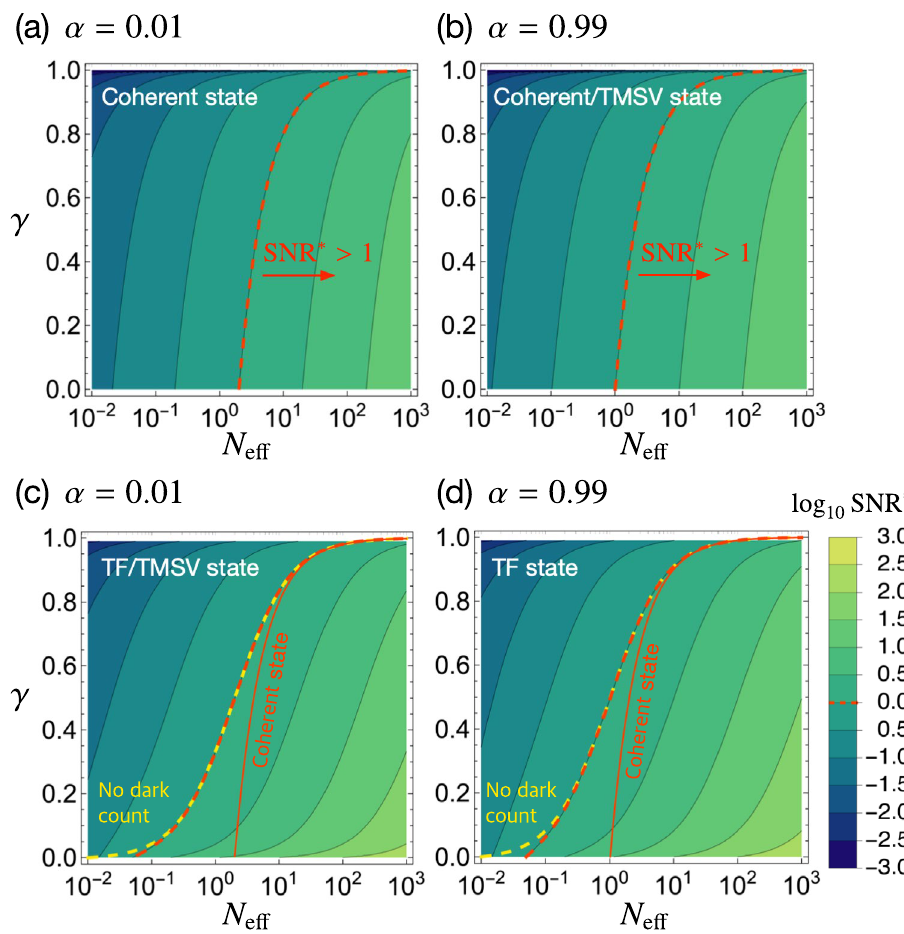
n 3 and δα 10 − 3 Figure 6. SNR ∗ of Eq. (5) in logarithmic scale as functions of γ and N eff for dark � = 10 = �ˆ assumed as an example. The SNR ∗ s for the cases using the coherent (upper panel), TF state (low panel), and TMSV state (upper and lower panels where appropriate) are respectively shown in the regimes of small alpha (left column) and large alpha (right column). The region where SNR ∗ > 1 is clearly distinguished in both upper and lower panel by the red dashed line according to Eq. (6). In lower panel, solid lines denote the boundary 1 for the coherent state input as in the upper panel, distinguishing the region with no quantum of SNR ∗ coh = n gain. Yellow dashed lines refers to the case of dark � = 0 �ˆ